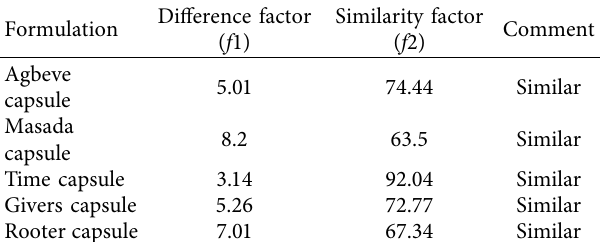
Table 7: Difference factor ( f 1) and similarity factor ( f 2) analysis between sampled liquid herbal antimalarials and their formulated capsules.